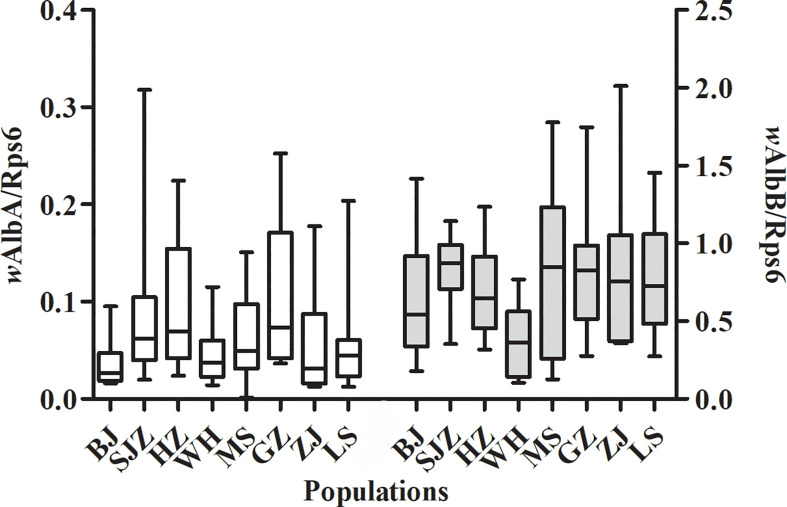
Relative densities of the wAlbA and wAlbB strains in Ae. albopictus from the eight populations in China.